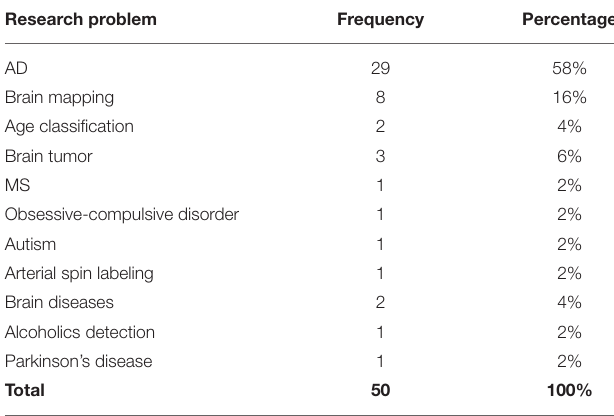
TABLE 6 | Different research problem discussed by the